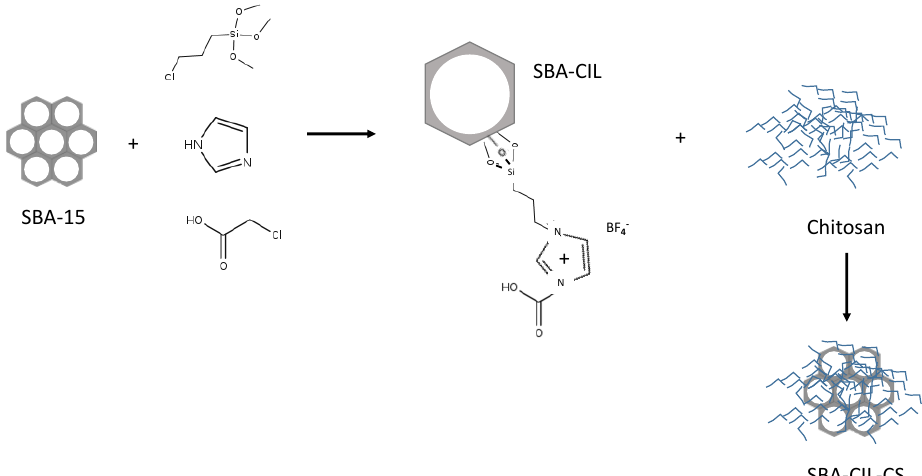
Figure 9. Schematic illustration of the synthesis procedure of SBA-CIL-CS.